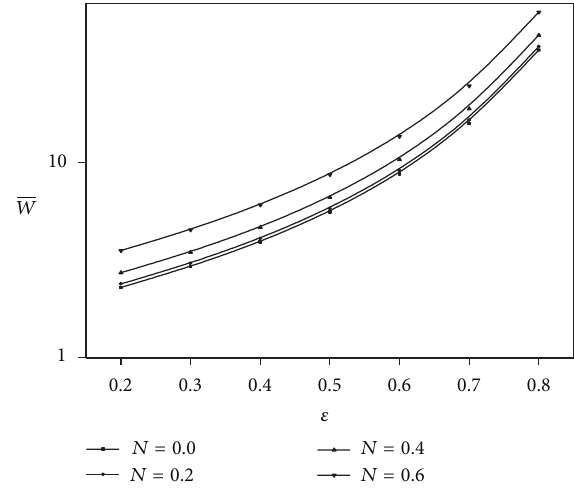
Figure 5: Variation of nondimensional load with 𝜀 for different values of 𝑁 with 𝑙 = 0.4 , 𝜆 = 0.5 , and 𝑄 = 0.5 . 100